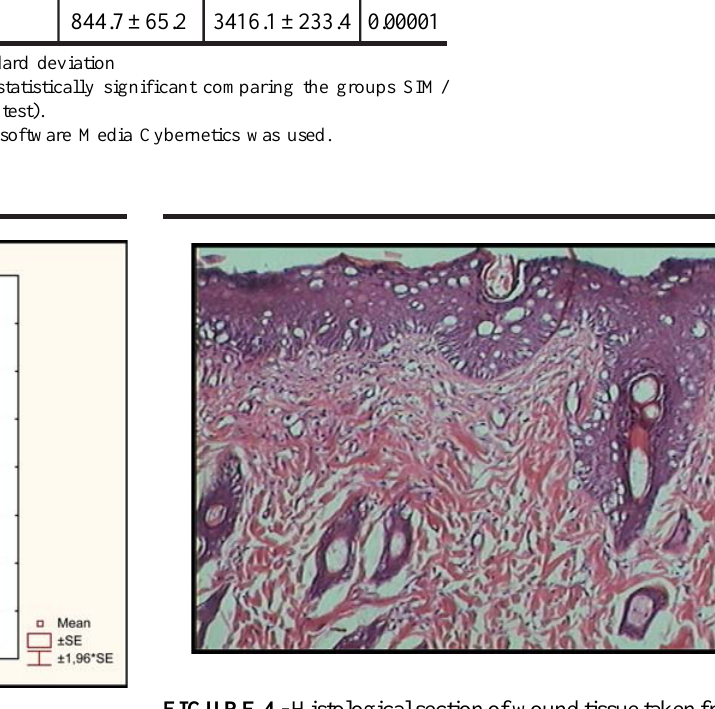
FIGURE 2 - Mean areas corresponding to the expression of IL-1 β Significant difference comparing the groups simvastatin and saline (p<0.05).